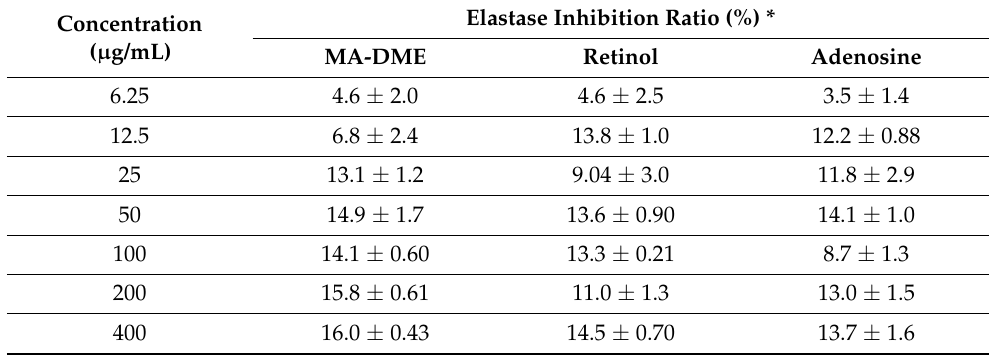
Table 3. Inhibition activity (%) of MA-DME targeting porcine pancreas elastase activity (0.4 U/mL).